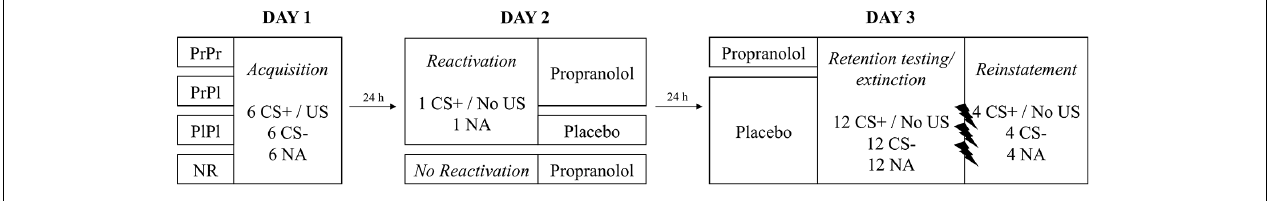
FIGURE 1 | Overview of the experimental design.